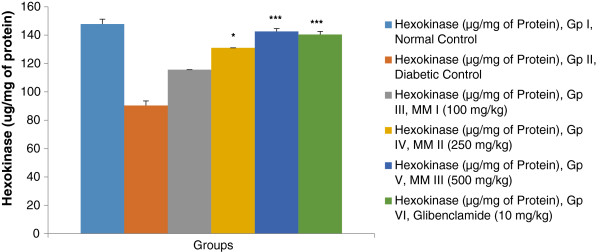
Effect of Melastoma malabathricum Linn. (MM) on level of hexokinase (μg/mg of protein) at different concentrations on STZ induced diabetic rats, compared to standard drug Glibenclamide; values are mean ± SEM; n = 6; *P < 0.05; **P < 0.01; ***P < 0.001; P > 0.05 is considered as non-significant (ns).